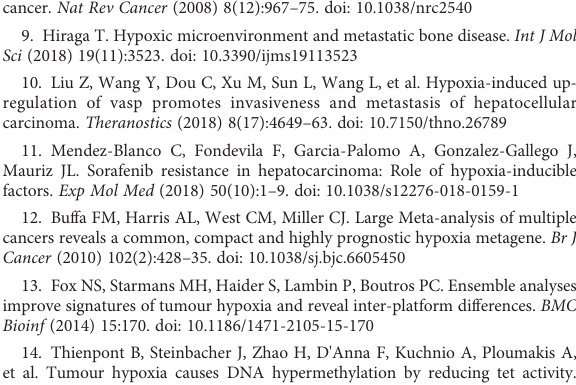
predicting the clinical outcomes of HCC patients with 2- and 3-year OS based on the TCGA-LIHC cohort. SUPPLEMENTARY FIGURE 6 Calibration of comprehensive nomogram and landscape of CNV of different hypoxic statuses. (A, B) Calibration plots for predicting the 2- year (A) and 3-year (B) OS of HCC patients in the TCGA-LIHC cohort. Nomogram-predicted probability of survival was plotted on the x-axis, and actual survival was plotted on the y-axis. (C, D) The landscape of CNV in high (A) and low (B) Hypoxia_DEGs_Score groups. SUPPLEMENTARY FIGURE 7 The beta value of DNA methylation differential sites in the different hypoxic statuses. (A) Heatmap exhibiting the beta value of 1104 DNA methylation differential sites in high and low Hyposia_DEGs_Score groups. (B) Heatmap displayed the beta value of top 50 DNA methylation differential sites in high and low Hyposia_DEGs_Score groups. SUPPLEMENTARY FIGURE 8 Changesofthetumorimmunemicroenvironmentingroupswithdifferent hypoxic statuses. (A – C) Scatterplots showing the correlation of the Hypoxia_DEGs_Score with the TIDE score (A) , in fi ltration of immunosuppressive cells (B) , and expression of TGF- b (C) according to Spearman ’ s rank correlation analysis in the TCGA-LIHC and ICGCLIRI-JP cohorts. Rs is the coef fi cient of rank correlation. SUPPLEMENTARY FIGURE 9 Relationship between the Hypoxia_DEGs_Score and drug response. (A) Correlation between the Hypoxia_DEGs_Score and drug sensitivity based on Spearman correlation analysis in GDSC. Each column represents a drug. The brightness of the column indicates the signi fi cance of the correlation. Rs is the coef fi cient of rank correlation. The height of the column indicates the correlation between Hypoxia_DEGs_Score and drug resistance (Rs > 0) or drug sensitivity (Rs< 0). (B) Signaling pathways targeted by ineffective (red) or effective (blue) drugs according to the Hypoxia_DEGs_Score. Drug names were listed on the horizontal axis and the signaling pathway targeted by the drug on the vertical axis. The bar graph on the right shows the number of drugs targeting each signaling pathway. (C) Dose-response curves for the the mean value of cell viability for BI-2536, RO-3306, FH535, and Akt inhibitor-VIII in the HCC cell lines HepG2 under hypoxic (red, n = 4) and normoxic (blue, n = 4)